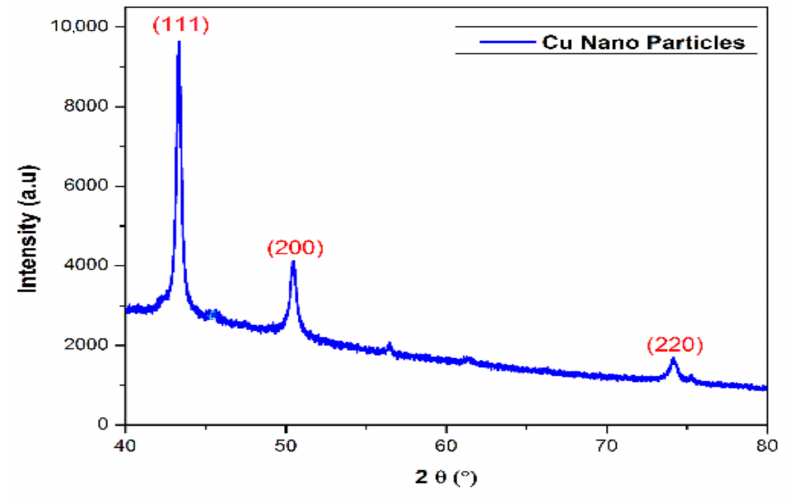
Figure 2. XRD Studies of telmisartan mediated copper